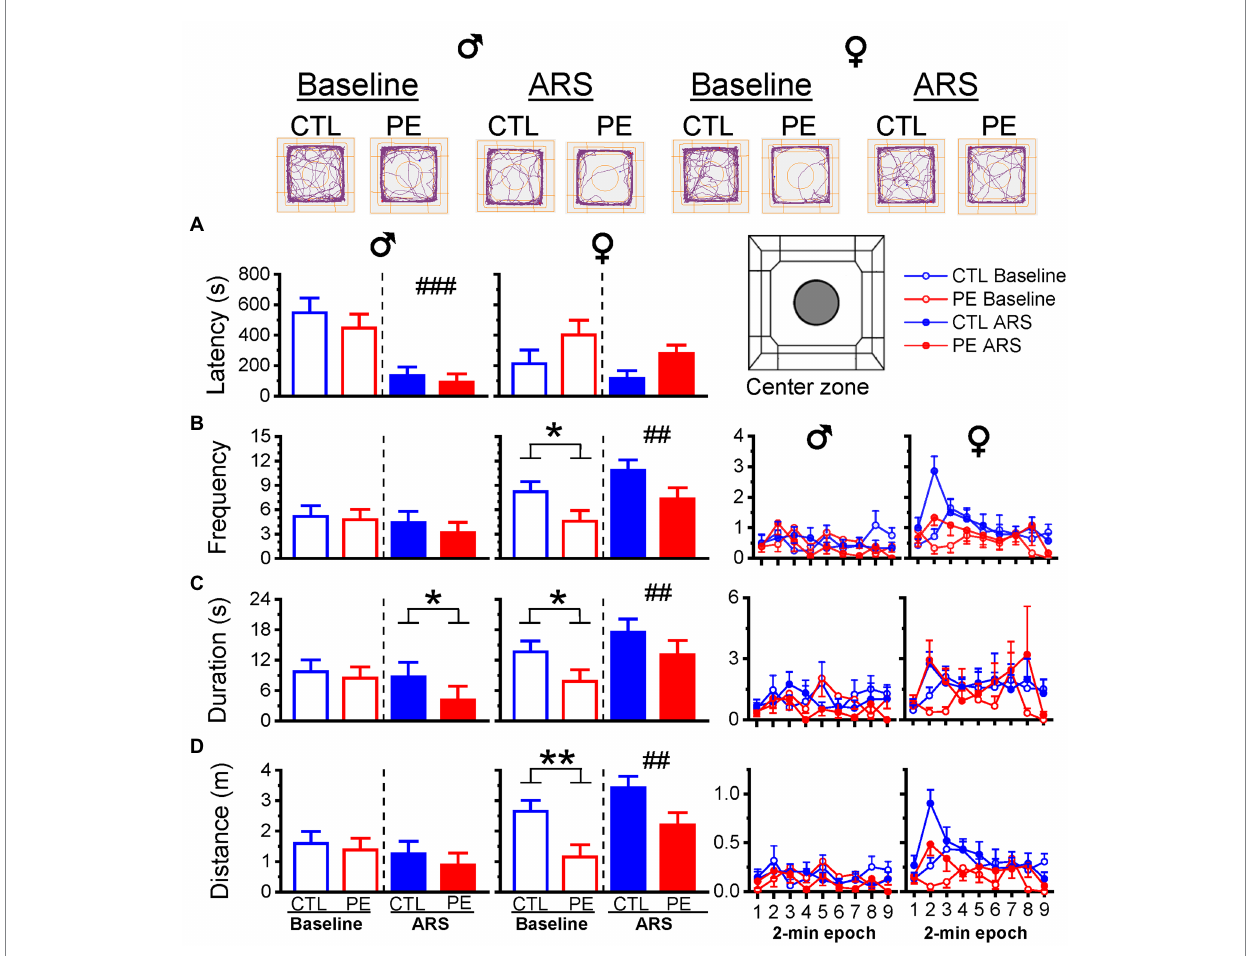
FIGURE 4 Prenatal ethanol exposure (PE) and acute restraint stress (ARS) effects on activities in the center zone. Upper panel reveals the representative tracking plots in the OF task. Prenatal ethanol exposure decreased the duration in the center zone after ARS in male rats (C) . Whereas, PE reduced the frequency, duration, and distance travelled under the baseline condition in female rats (B–D) . Prenatal ethanol did not impact the latency in males and females (A) . The right panels display the frequency, duration and distance of activities in the center zone in 2-min epoch. Data are represented as Mean ± SEM. * p ≤ 0.05, ** p < 0.01, control vs. PE. ## p < 0.01, ### p < 0.001, baseline vs. ARS. CTL,